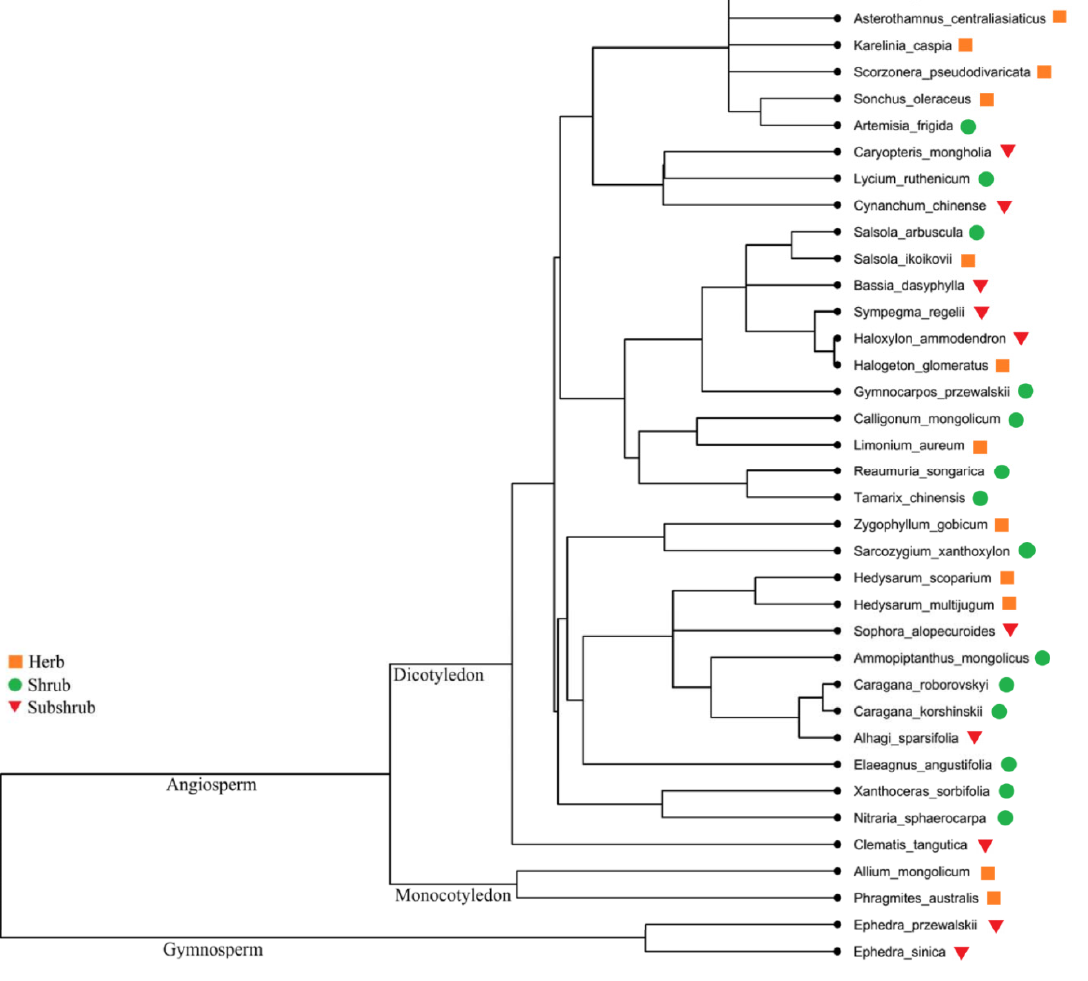
Figure 1. Phylogenetic structure of 37 species in the study area.